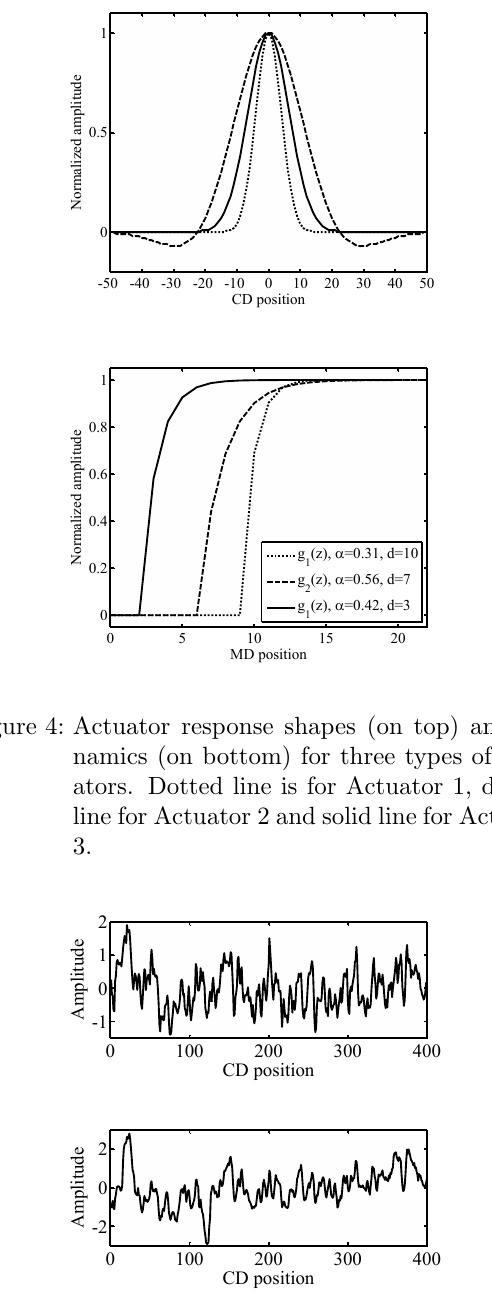
Figure 5: Steady-state disturbance profiles for Prop- erty 1 (on top) and Property 2 (on